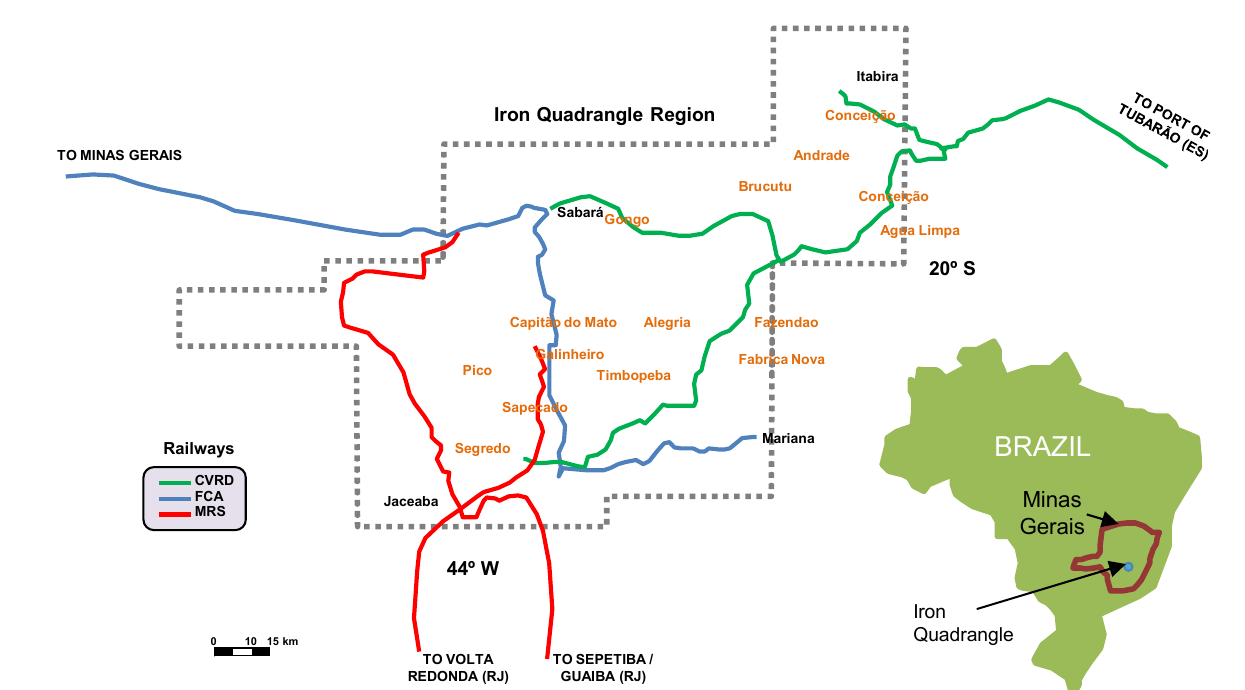
Figure 1. Map of the Iron Quadrangle region (Minas Gerais, Brazil). Adapted from [15].